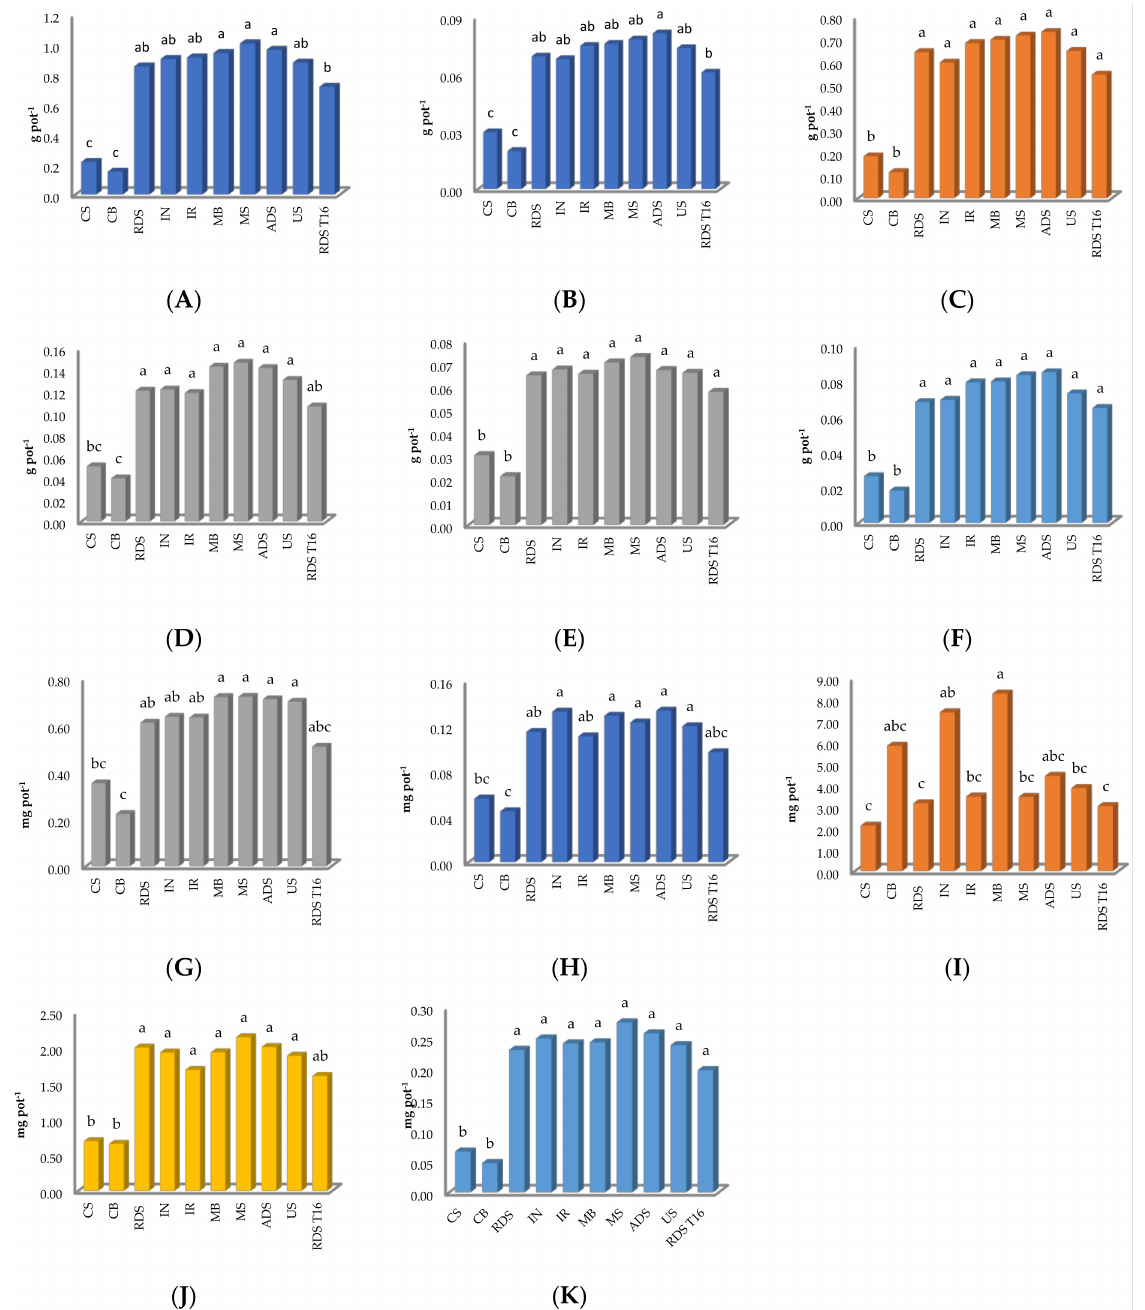
Figure 1. Nutrients recovered by aboveground ryegrass biomass harvesting (Means of three repli- cates). Nitrogen ( A ), Phosphorus ( B ), Potassium ( C ), Calcium ( D ), Magnesium ( E ), Sulphur ( F ), Zinc ( G ), Boron ( H ), Iron ( I ), Manganese ( J ), Copper ( K ). Different letters on the columns indicate significant differences at p < 0.05 for treatments, according to the Tukey